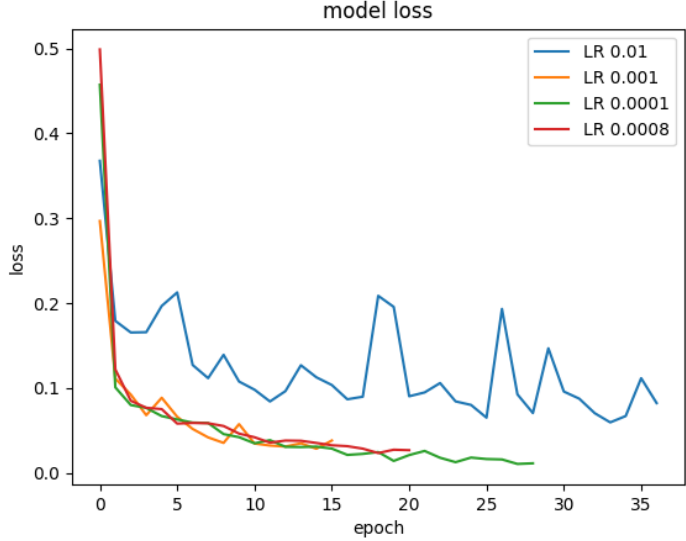
Figure 16. The loss of the model on various learning rates.